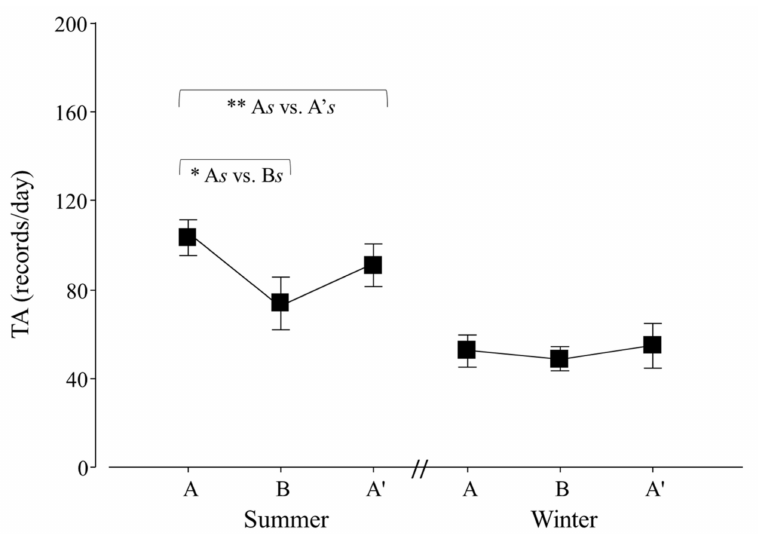
Figure 6. Total activity (TA) per day of adult Tamandua tetradactyla ( n = 6 females and 6 males) exposed to semi-controlled conditions, in response to seasonal transports (applied in B) during summer and winter. The ABA experimental design applied: day 0 (previous-stage A), days 1 and 2 (disturbance—stage B) and day 3 (posterior-stage A (cid:48) ). Behaviour was recorded every 5 min (252 records/day/individual), and number of activity records per day during each stage per season was calculated. Asterisks indicate significant differences between stages during seasons for all individuals (* A s (cid:54) = B s , ** A s (cid:54) = A (cid:48) s ; p values in the text). Results are expressed as the mean ±